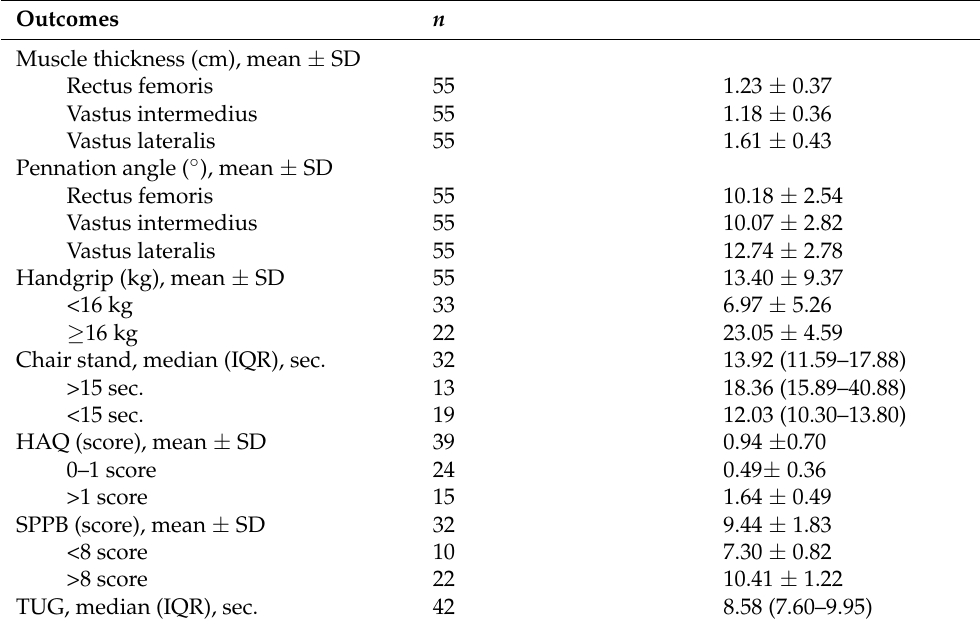
Table 2. Muscle thickness, pennation angle, muscle strength and physical function outcomes data of RA